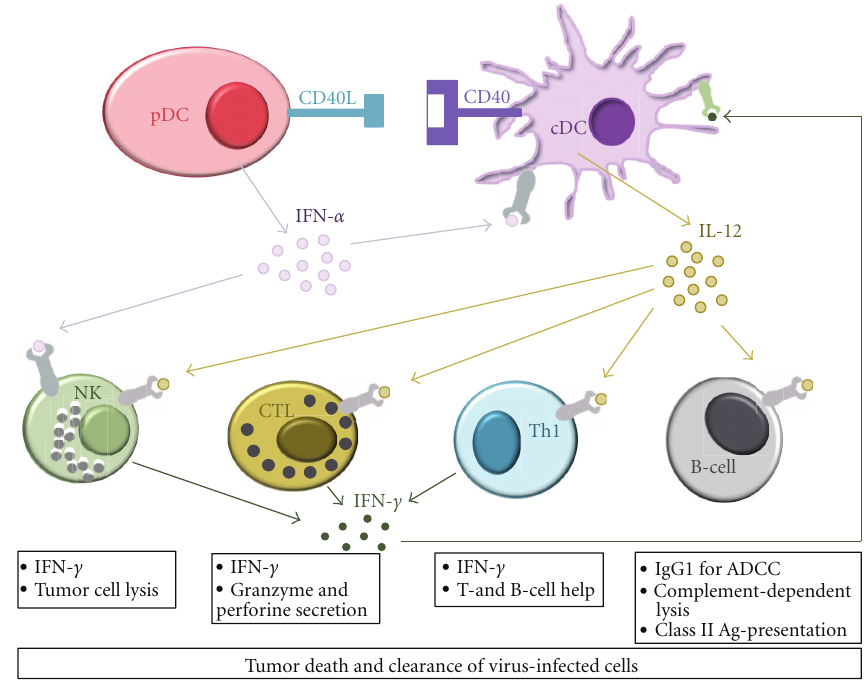
Figure 1: Cooperative action of di ff erent DC subsets to tackle both innate and adaptive immunity for clearance of tumors and viral